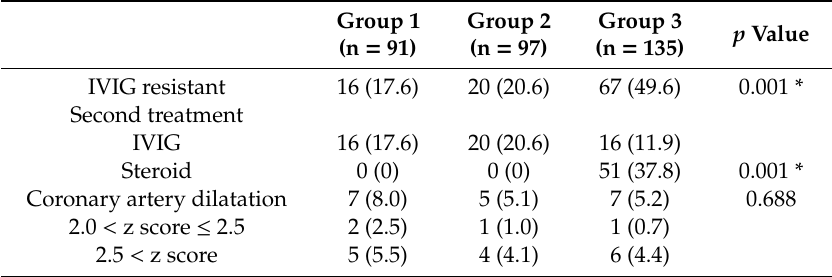
Table 6. Comparison of clinical prognosis among